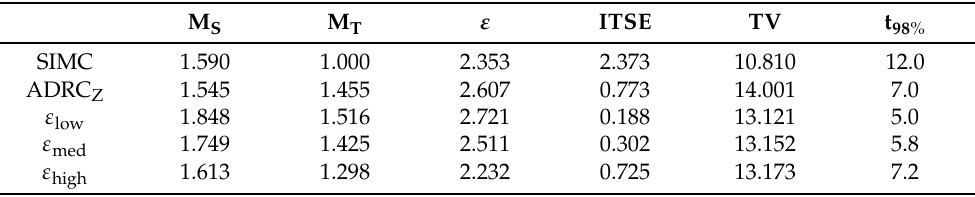
Table 10. Performance comparison of proposed tuning rules with reference controllers for the load disturbance response of the Peltier